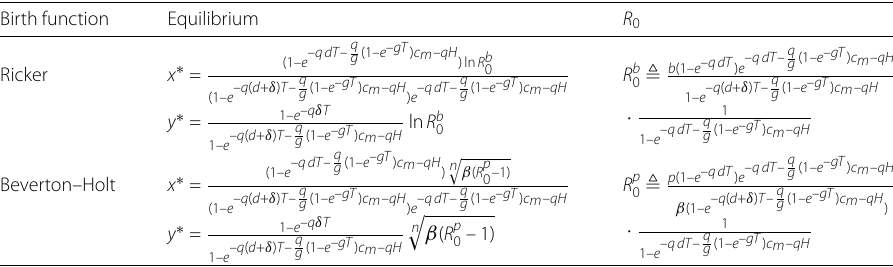
Table 1 The positive equilibrium and the threshold of model (3.2) and (3.3) Birth